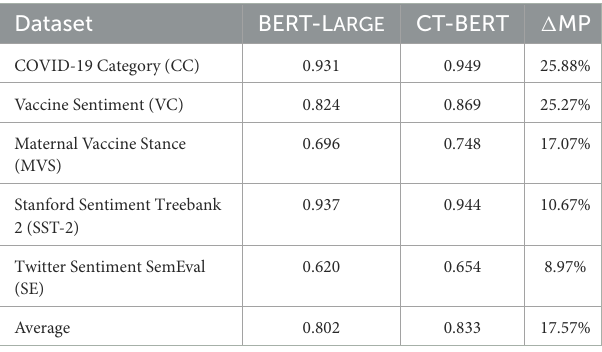
TABLE 2 Comparison of the final model performance with BERT-LARGE.